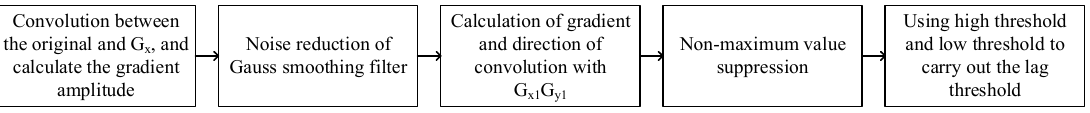
Figure 6. Edge detection results for the ( a ) grayscale image of the original graph using various operators, including the ( b ) Roberts, ( c ) Prewitt, ( d ) Sobel (X direction), ( e ) Sobel (Y direction), ( f ) Sobel (standard), ( g ) Canny, and ( h ) Laplace operators.